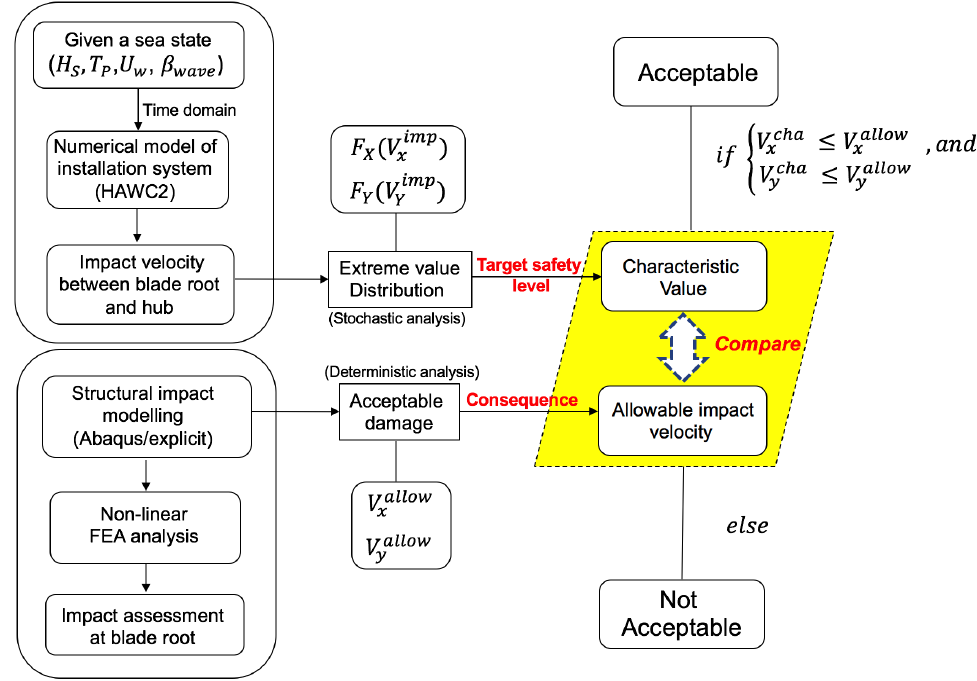
Figure 5. Response-based methodology for estimating operational limits for blade-root mating